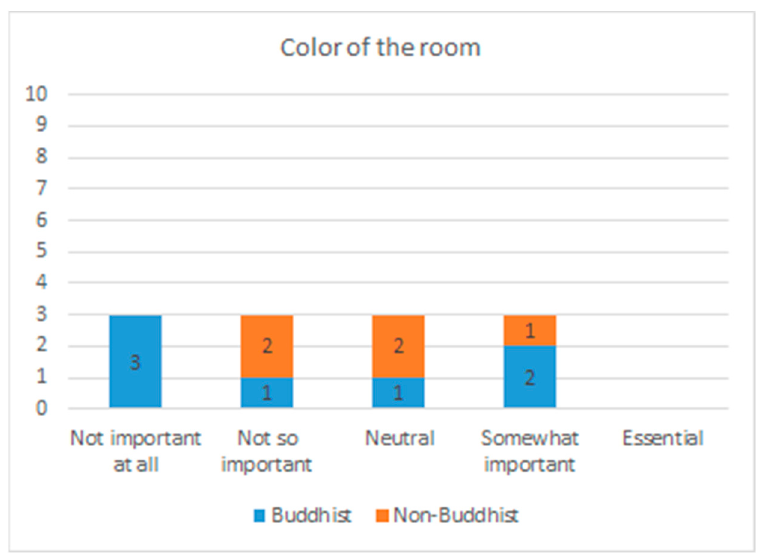
Figure 10. Results from responses to the question: “Please rate how important each of these physical elements is to you, as a means of supporting your practice and your intention to be mindful—color of the room”.